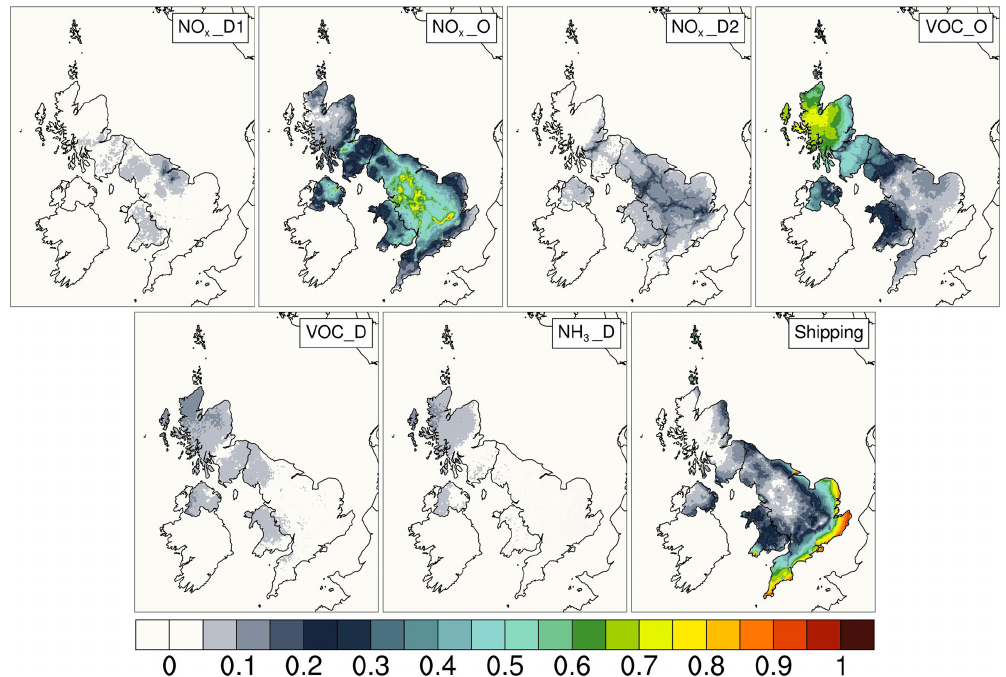
Figure 3. Spatial distributions (at the 5km × 5km model grid resolution) of the first-order sensitivity indices for modelled surface con- centrations of O 3 . D indicates emissions from a dominant sector and O indicates grouped emissions from the rest of the sectors. For NO x emissions the dominant sectors are energy production (D1) and road transport (D2); for VOC emissions solvent use is dominant, and for NH 3 agriculture is dominant. The shipping emissions variable combines emissions of all relevant